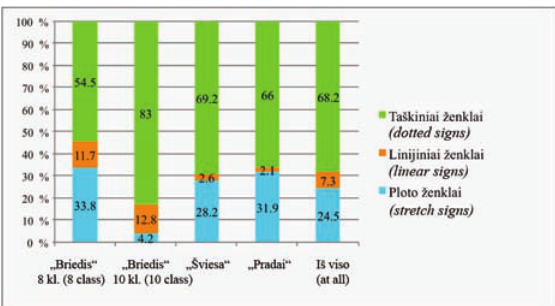
Fig. 1. Dotted, linear and stretch sign distribution in the analysed maps of scholastic geographical